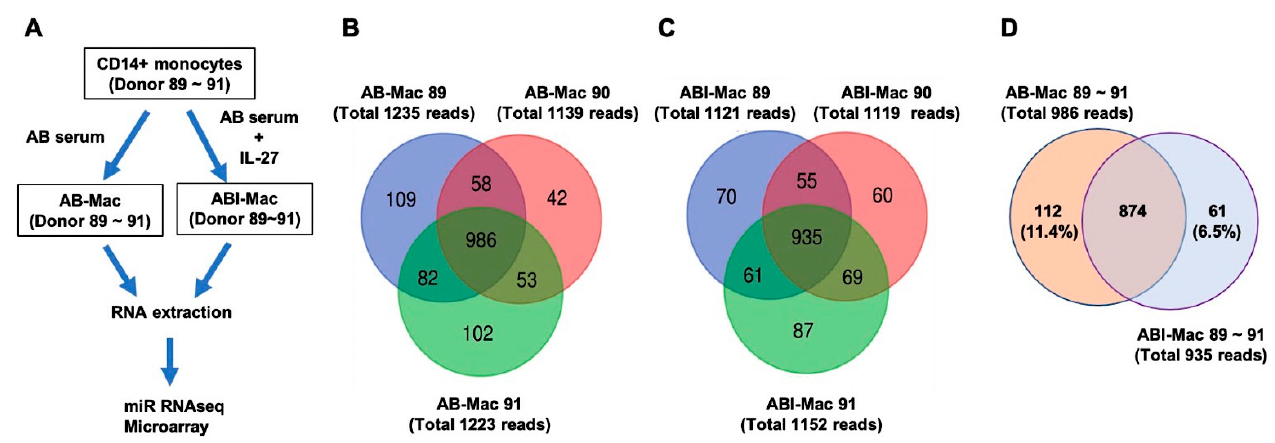
Figure 1. Comparison of known miRNA profiles between AB- and ABI-Macs. ( A ) The diagram depicts the protocol for the preparation of AB- and ABI-Mac from fresh CD14+ monocytes of three independent donors (Donor 89~91) using human AB serum without or with IL-27. ( B , C ) Known miRNA profiles in AB-Mac ( B ) and ABI-Mac ( C ) were compared among the donors’ data and the Venn diagram analysis was carried out. ( D ) A profile of 986 known miRNAs commonly expressed in the three donors’ AB-Mac was compared with that of 935 common miRNAs of ABI-Mac and the Venn diagram analysis was performed.